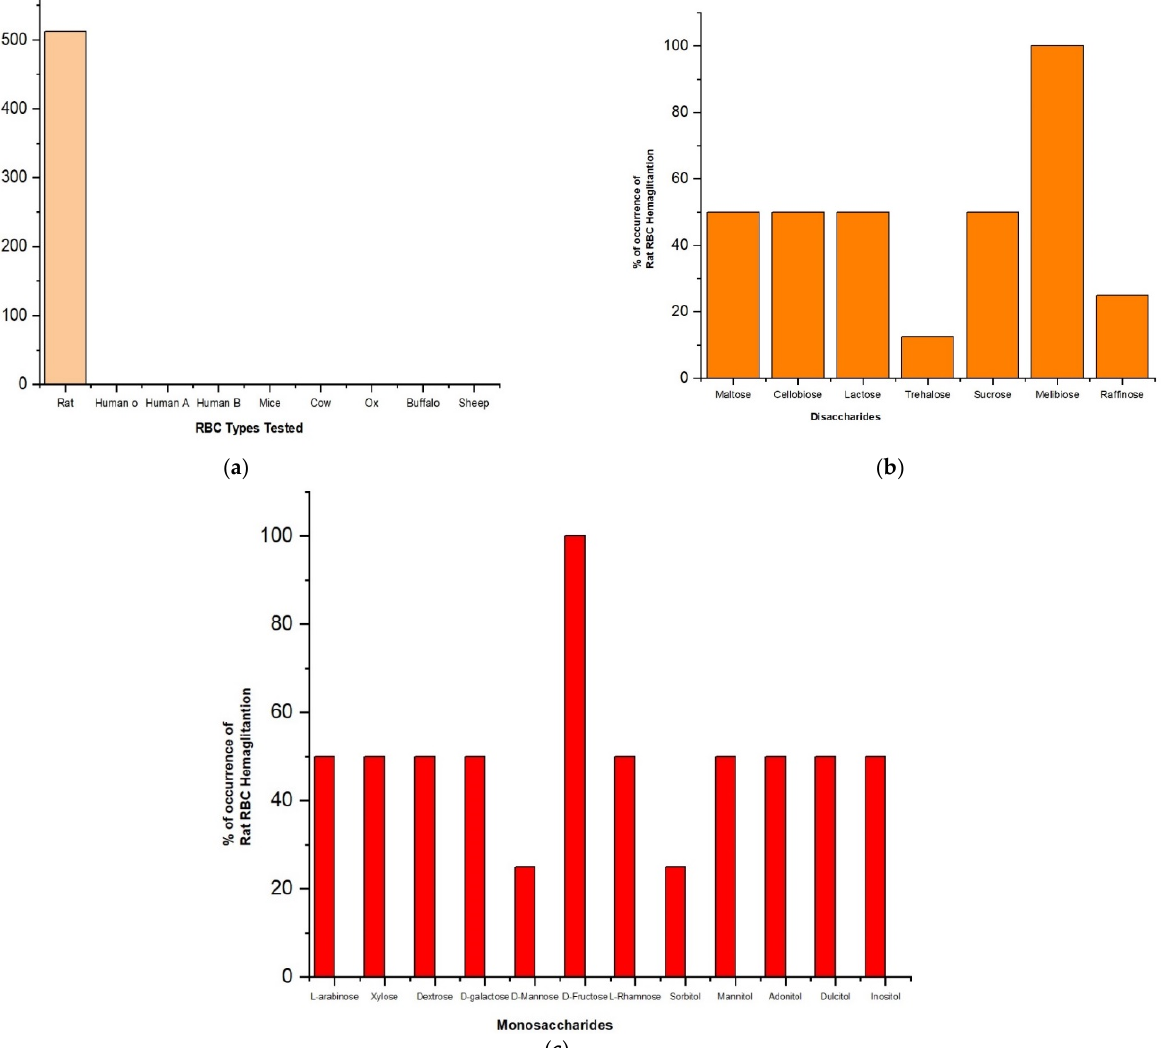
Figure 8. ( a ) Hemagglutination (HA) activity of LBP against various mammalian RBC types. ( b , c ) Carbohydrate inhibition assay on Rat ‐ RBC hemagglutination activity of LBP. ( b , c ) Carbohydrate inhibition assay on Rat-RBC hemagglutination activity of